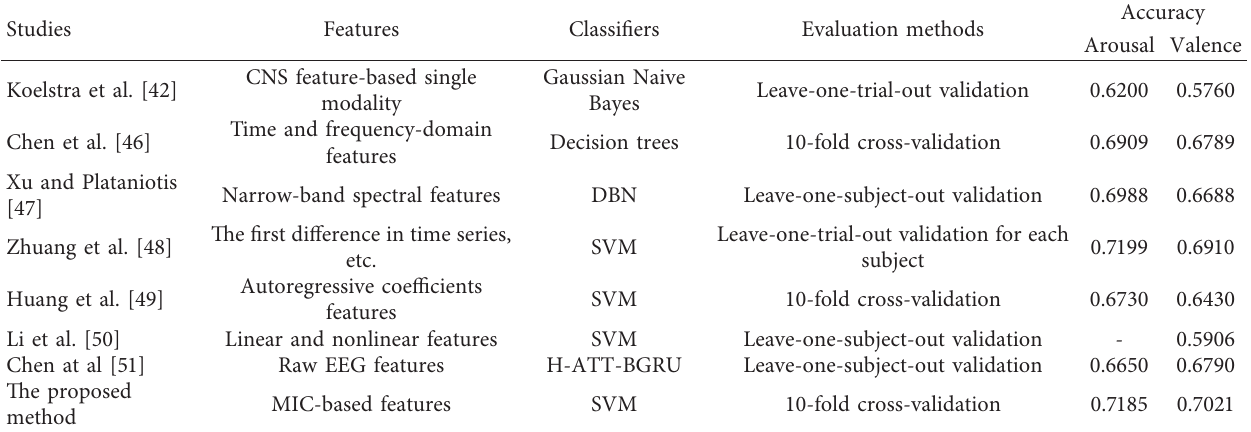
Table 4: Details from comparison